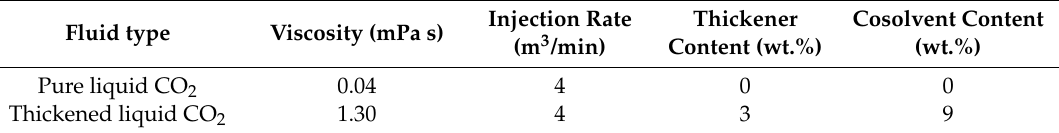
Table 3. The Detailed parameters of fracturing fluids for numerical simulation in this